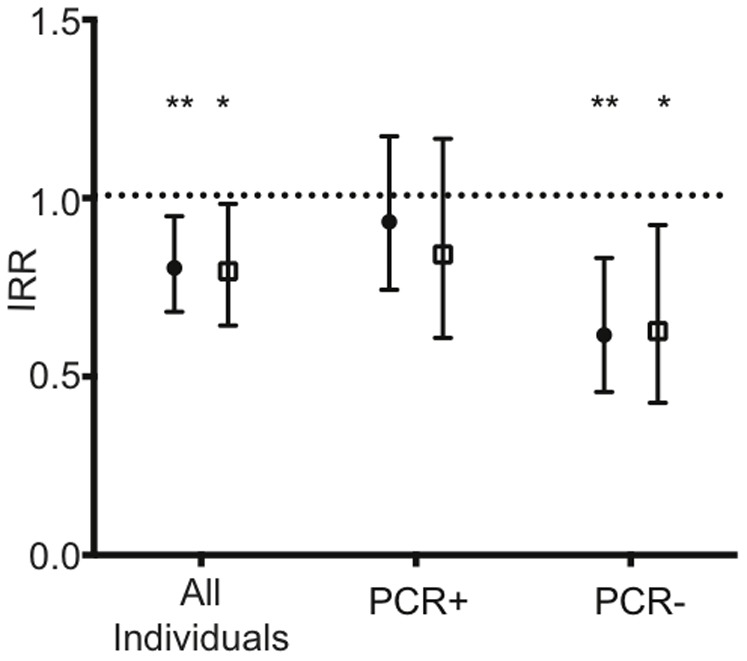
Incidence of clinical malaria episodes during follow-up relative to opsonising antibody responses.Incidence rate ratios (IRR) for %phagocytosis20 and the incidence of clinical malaria episodes over the 6 months of follow up were calculated for all individuals and after stratification based on PCR+ P. falciparum infection at baseline. Values represent un-adjusted IRR (filled circle) and adjusted IRR (age and location adjusted, open squares) ±95% confidence intervals, and asterisks mark significant associations (* p<0.05,** p<0.01).